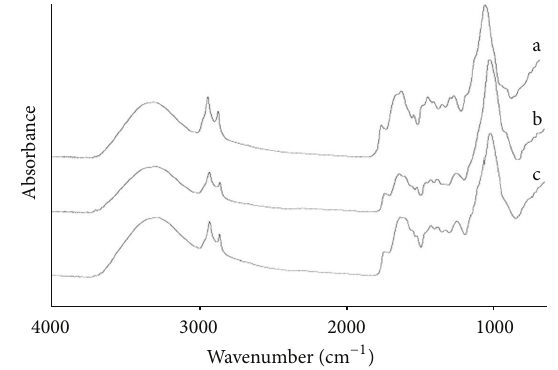
Figure 1: FT-IR spectra of the Radix Bupleuri and its unofficial varieties. a. Radix Bupleuri ; b. root of the Bupleurum smithii Wolff; c. root of the Bupleurum bicaule